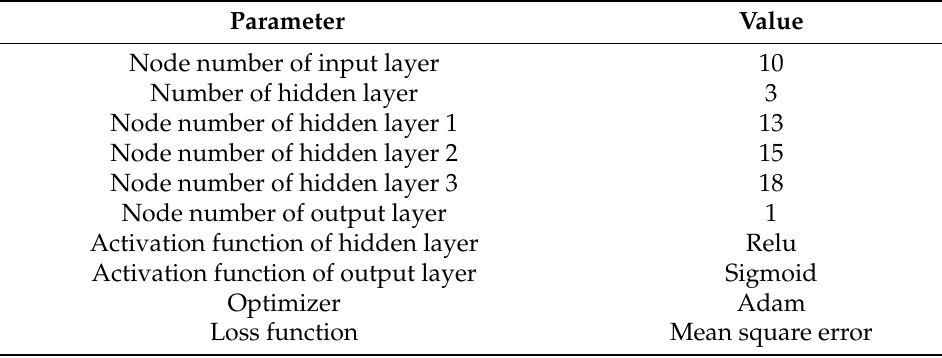
Table 3. ANN model parameters.